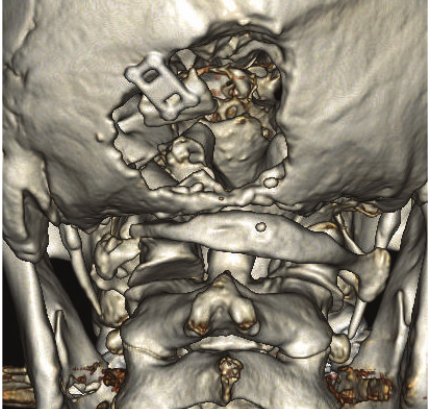
Figure 2: Computed tomography of the head and neck when the patient was referred to our hospital. Defects are observed in the left side and midline of the occipital bone.